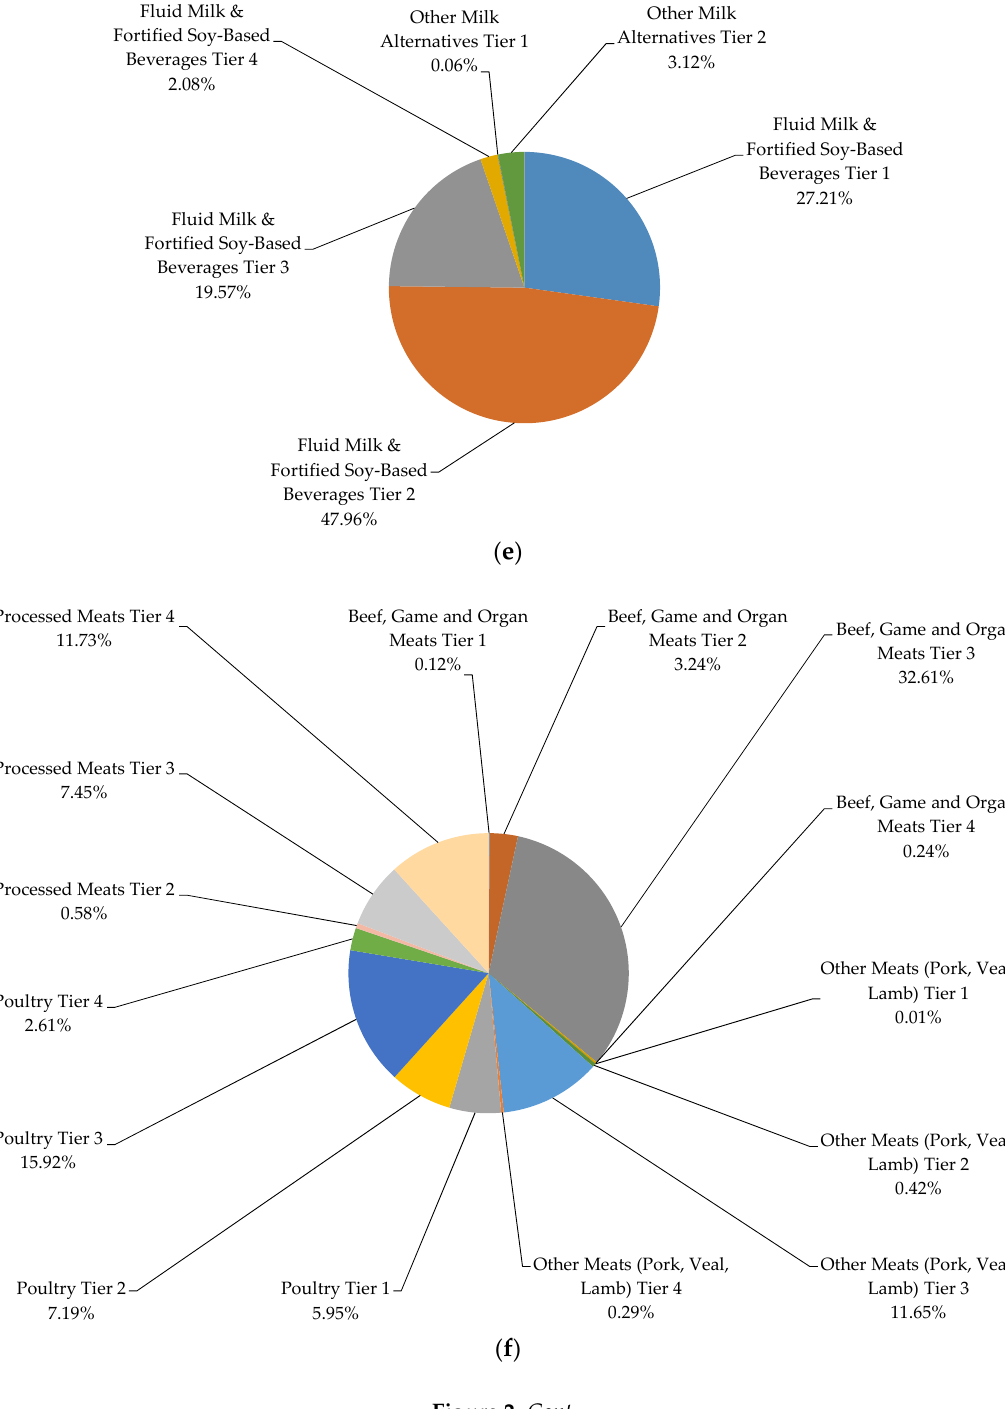
Figure 2. Cont. Figure 2.